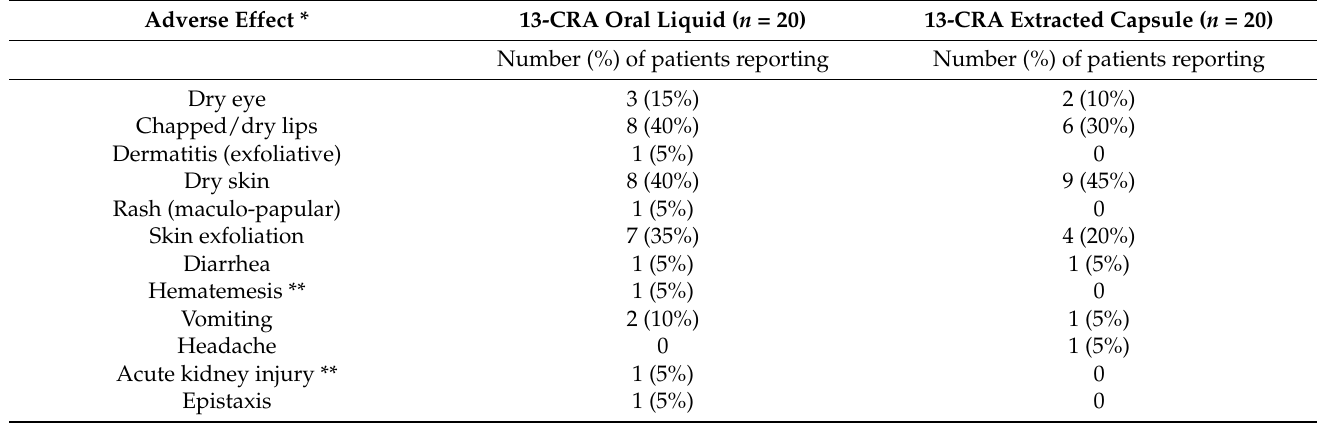
Table 2. Summary of drug-related adverse